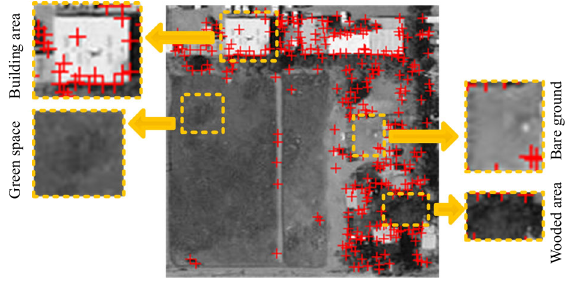
Fig. 4 Keypoints distribution after